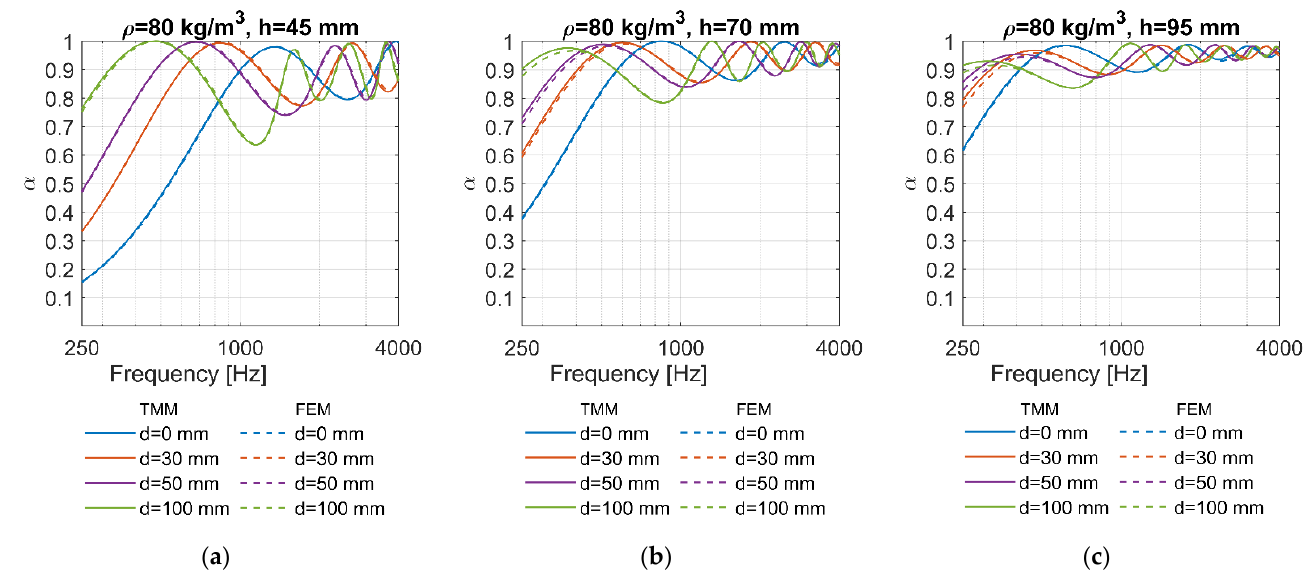
Figure 14. Sound absorption coefficients for different air gap thicknesses, ρ = 80 kg/m 3 .